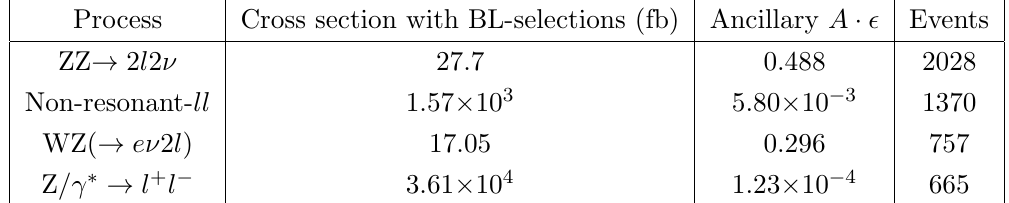
Table 5 . Background estimation with cross sections calculated in a phase space with BL-selections and ancillary A (cid:15) to obtain the same event rate as in table 3 of ref. [11]. The number of events has (cid:1) been translated into 150 fb (cid:0) 1